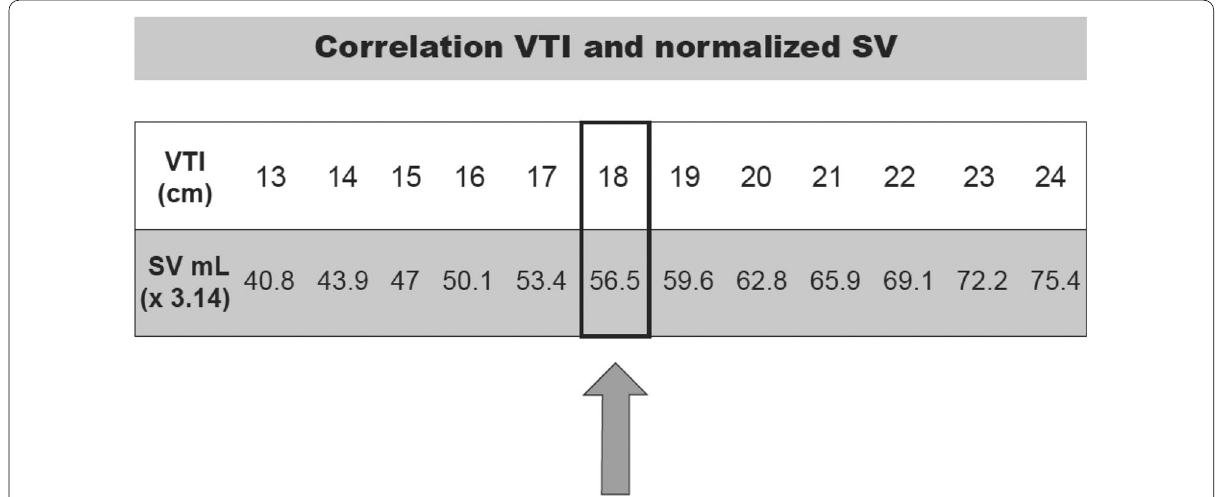
Fig. 3 Correlation of VTI and normalized